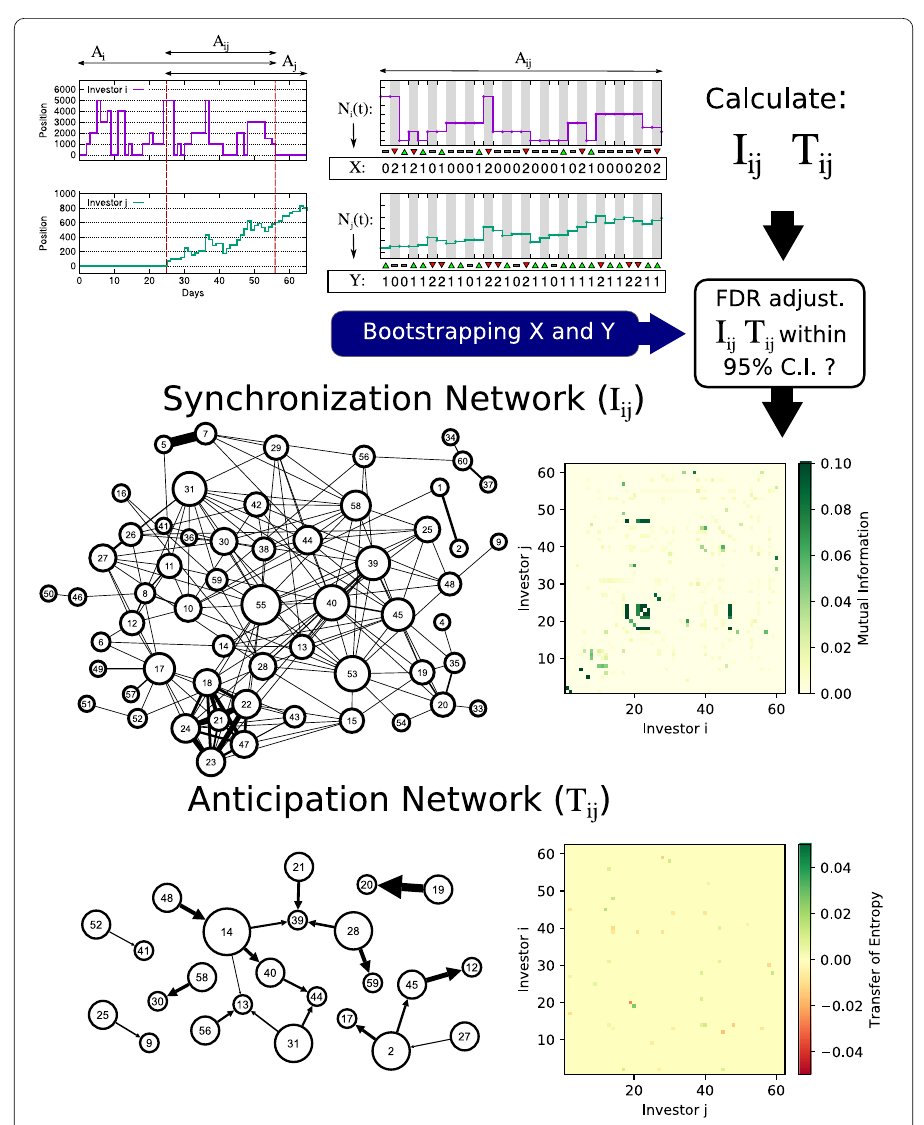
Figure 1 Method for generating the Synchronization and Anticipation networks. (Top-left) From the position time series N i ( t ) and N j ( t ) of each pair of investors i and j we determine the activity period of each investor ( A i and A j ) together with the corresponding overlapping period of activity A ij . (Top-center) Considering only values within the overlapping period we codify the position time series into symbols, using in this particular case with embedding dimension m = 2, to generate symbolic time series X and Y . (Top-right) We use these symbolic time series to compute the values for Mutual Information I ij and Transfer of Entropy T ij . In parallel, we apply a bootstrapping process to X and Y to extract a distribution of null values I ∗ ij and T ∗ ij , which we use to apply the FDR procedure explained in “Methods”. Then, we keep all values within the 95% Confidence Interval, manually setting the rest to 0 for the non-significant, to create the adjacency lists for Synchronization Network (Center-right) and Anticipation Network (Bottom-right) for REP market. The networks are generated considering investors as nodes and edge weight as the corresponding values of I ij and T ij respectively. Size of the nodes is proportional to the node degree for Synchronization network and to the out-degree for the Anticipation network. Numbers inside each node are used as an ID of the investor